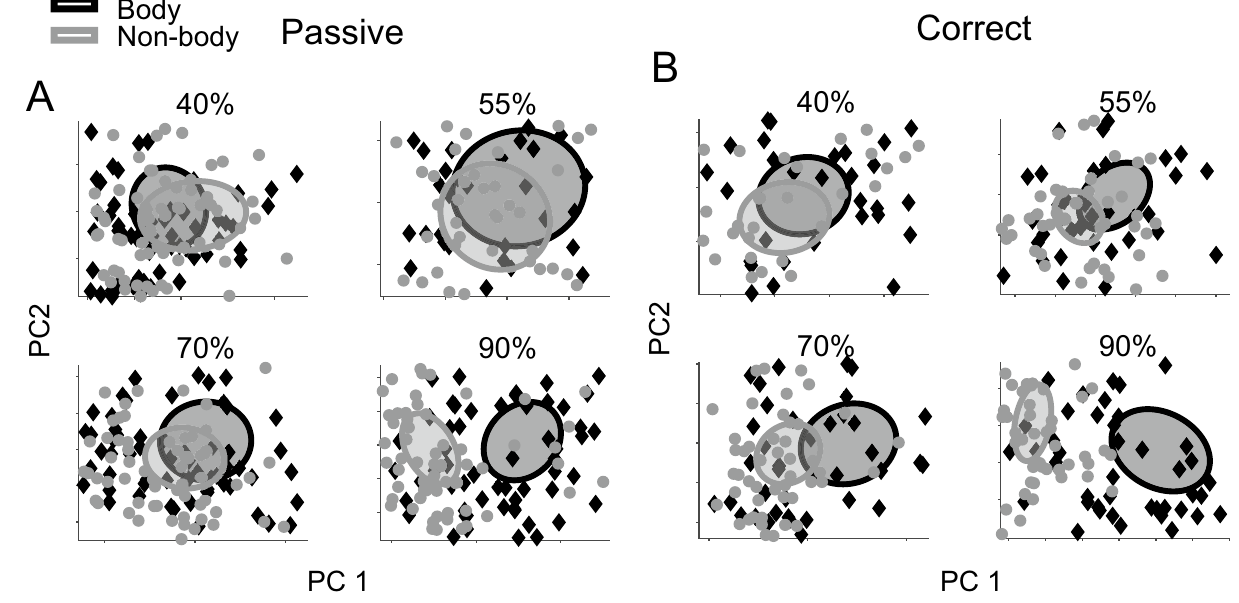
Figure 2. Low dimensional representation of subcategories in IT neural population activity. Representation of the categories in the first two most informative dimensions of the principal component analysis is shown for passive ( A ) and correct ( B ) trials. Ellipses demonstrate two standard deviations of the distribution of category members in the 2D representations. Diamonds and circles show body and non-body stimuli,